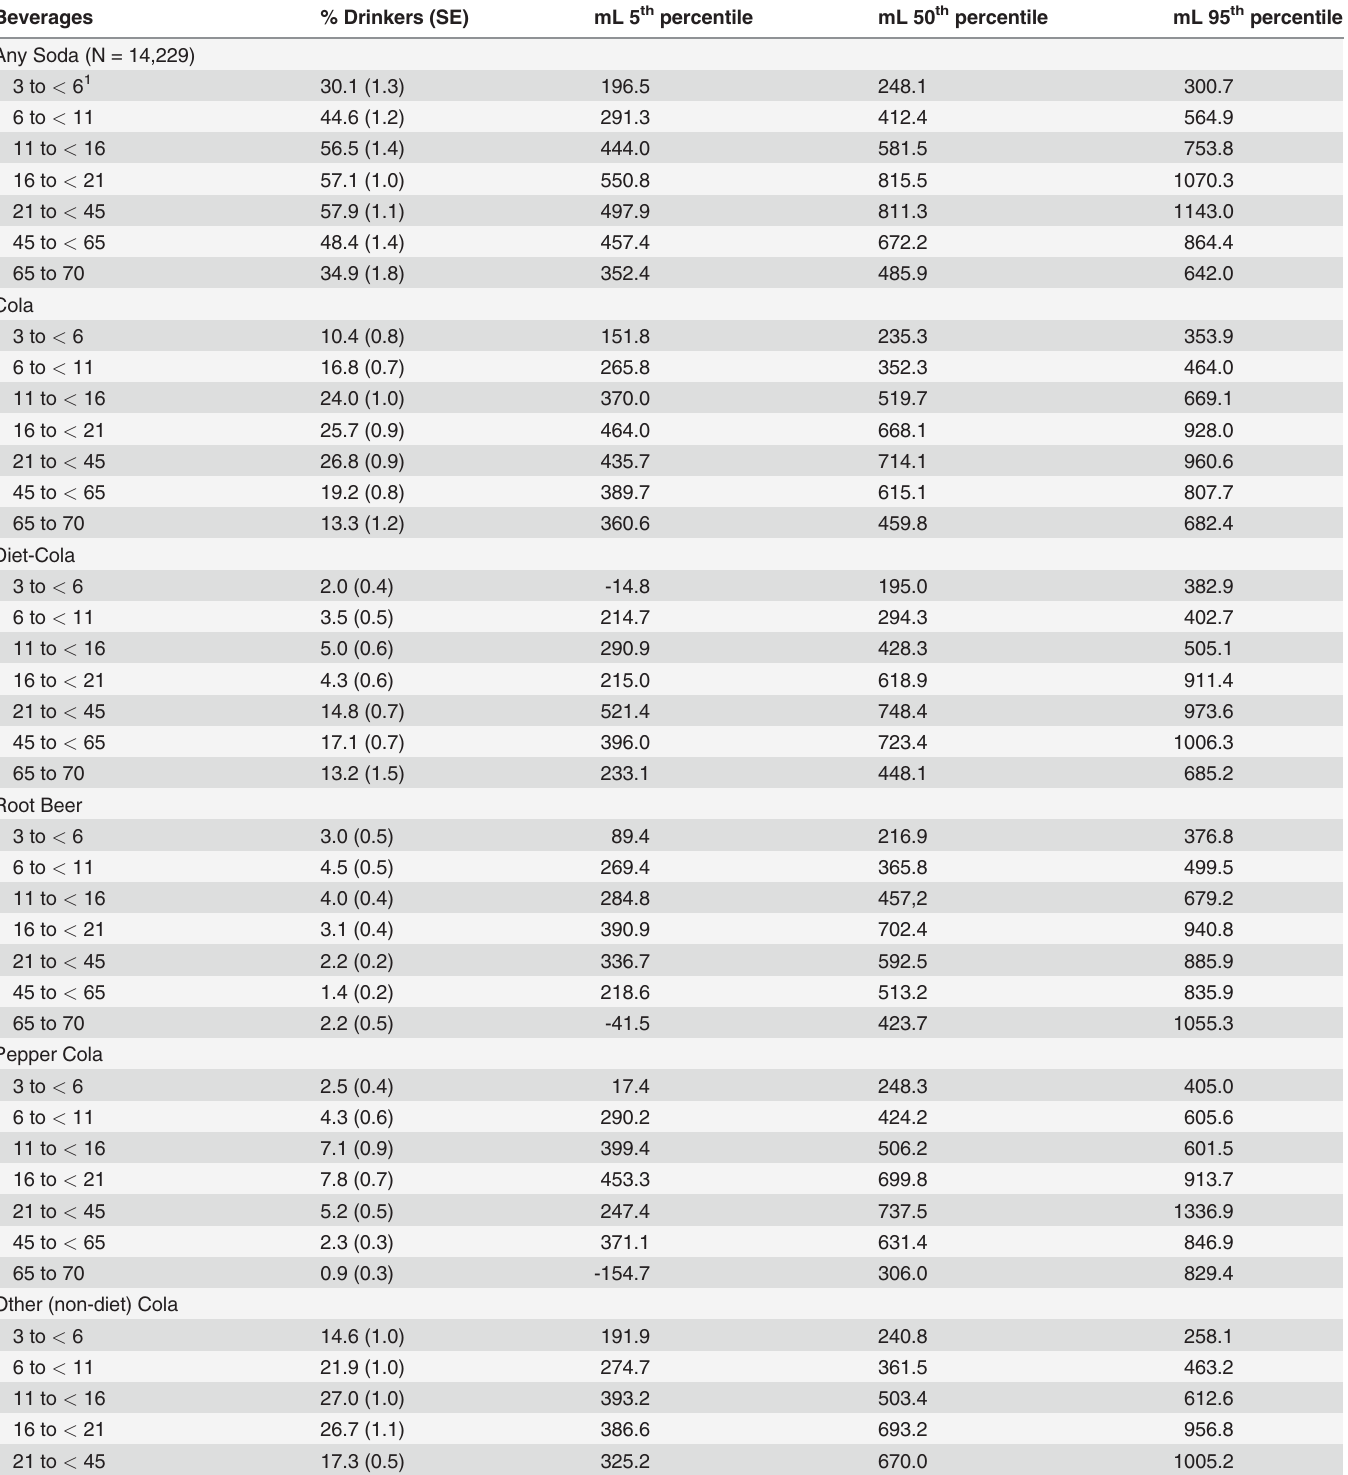
Table 3. Average Daily Intake in Volume (mL) among Beverage Drinkers, by Beverage and Lifestage, NHANES 2003 – 2010 (N =